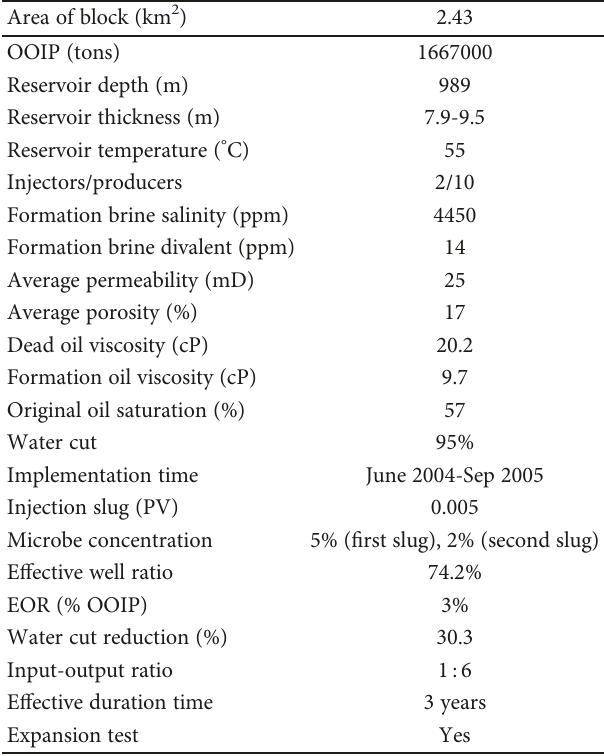
Table 4: Chao 50 block microbial fl ooding fi eld test in Daqing Oil fi eld [61 –